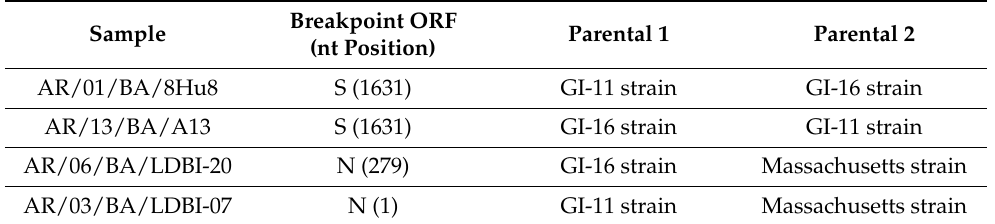
Table 2. Unique recombinants of GI-11 and GI-16 lineages. The table shows the recombinant strains, the parental strains, and the ORF nucleotide (nt) position of the breakpoints. The recombinant event of the GI-11 strains occurred in a previously ancestral recombinant genome. Breakpoint ORF Parental 1 Parental 2 Sample (nt Position) AR/01/BA/8Hu8 S (1631) AR/13/BA/A13 GI-16 strain AR/06/BA/LDBI-20 N (279) GI-16 strain AR/03/BA/LDBI-07 N (1) GI-11 strain Massachusetts